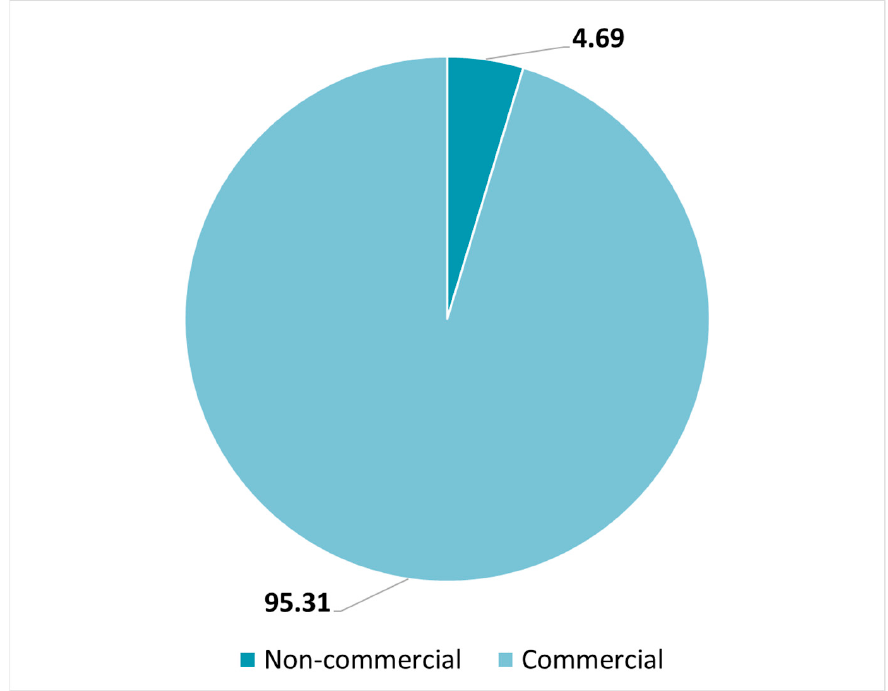
Figure 2. Percentage of commercial and non-commercial CTs assessed and authorized from 2018 to 2020, including a nanomedicine tested as an IMP.